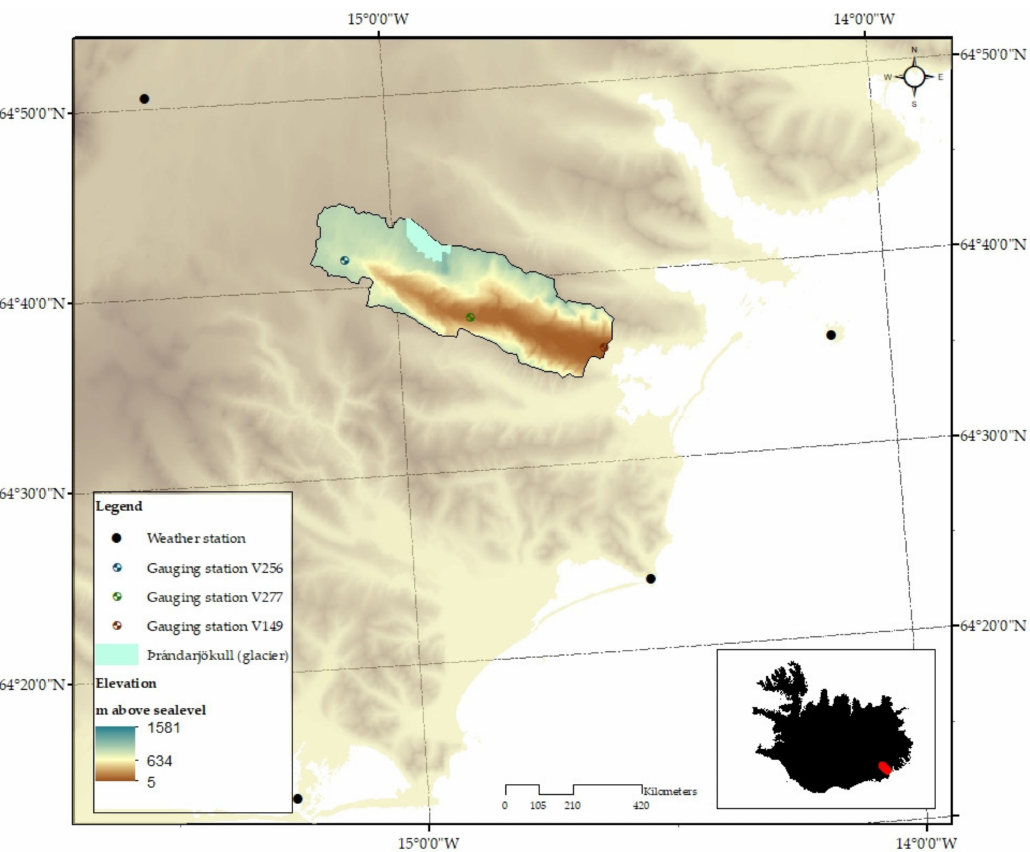
Figure 1. Overview of the Geithellna á catchment in South East Iceland. Glacial, river, and boundary data from National Geosurvey of Iceland